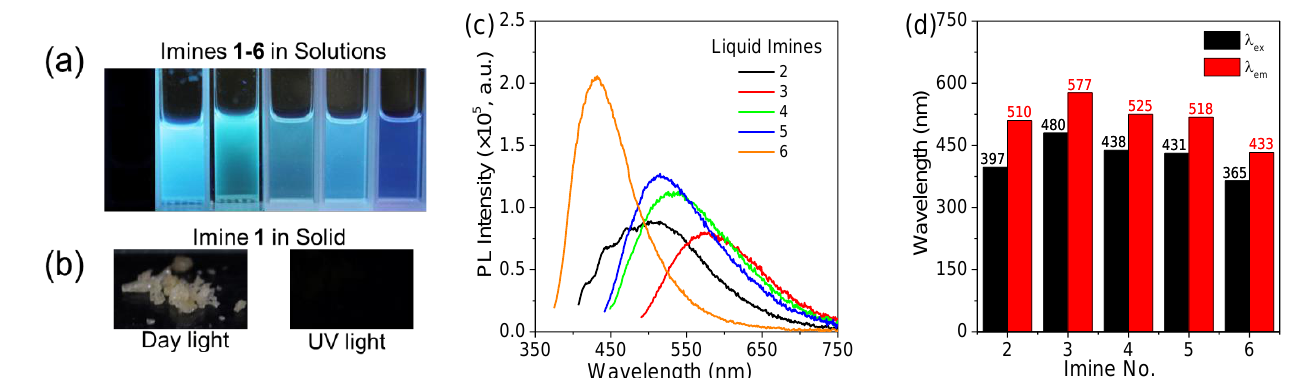
Figure 2. ( a ) Photographs of imines 2-6 ethanol solutions (5 vol.%) under 365 nm UV light, and ( b ) photographs of imine 1 solid powders under daylight and 365 nm UV light. ( c ) Fluorescence emission spectra of pure imines 2-6 in liquid state, and ( d ) their maximum excitation wavelength (black) and maximum emission wavelength (red).